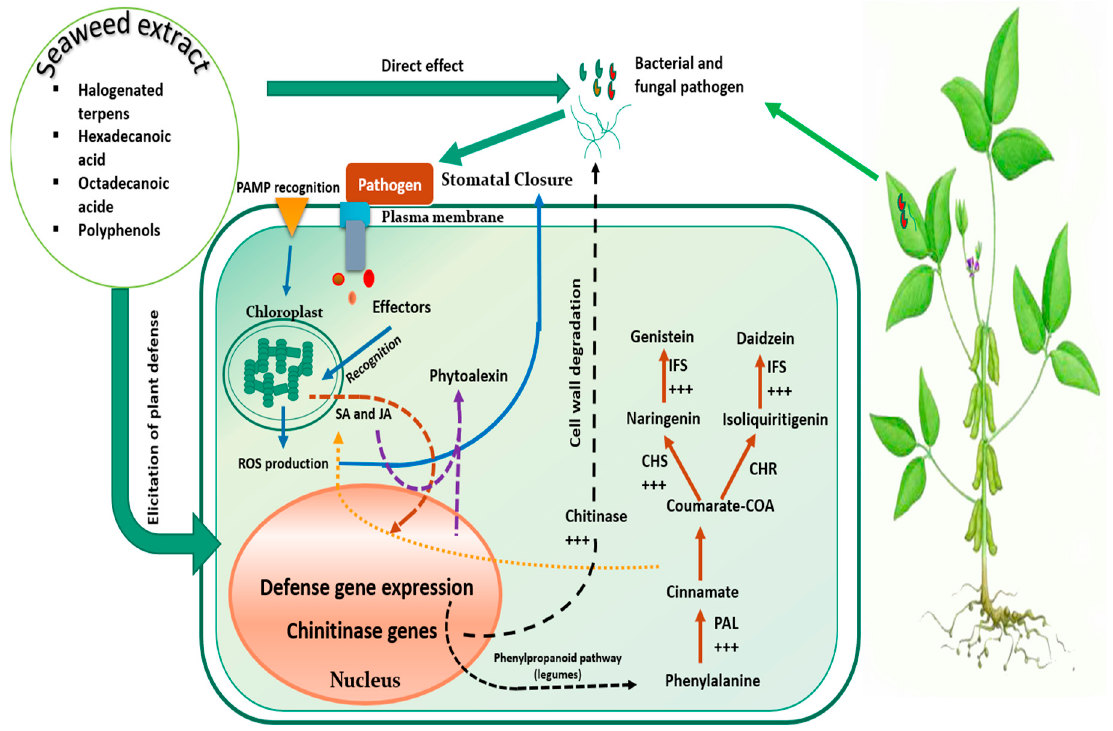
Figure 5. Conceptual illustration highlighting plausible mechanisms of action of seaweed extract with respect to fungal and bacterial disease control: seaweed extract may affect directly pathogen agents or indirectly through eliciting the plant defense machinery Such elicitation occurs via the up regulation of several defense genes, thus positively affecting specific metabolic pathways, namely the phenylpropanoid pathway, which induce the biosynthesis of several secondary metabolites involved in disease suppression. JA: Jasmonic acid, SA: Salycilic acid, PAL: Phenylalanine ammonia-lyase, CHS: Chalcone synthase, CHR: Chalcone reductase, IFS: Isoflavone synthase, IFR: Isoflavone reductase.